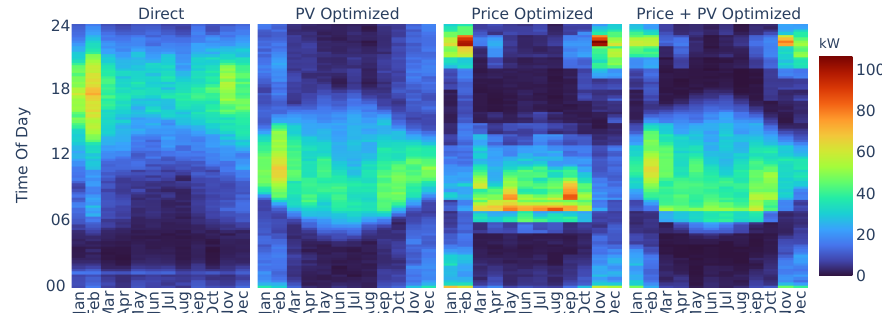
Figure 13. Aggregated average for EV charging power throughout the year for the different charging